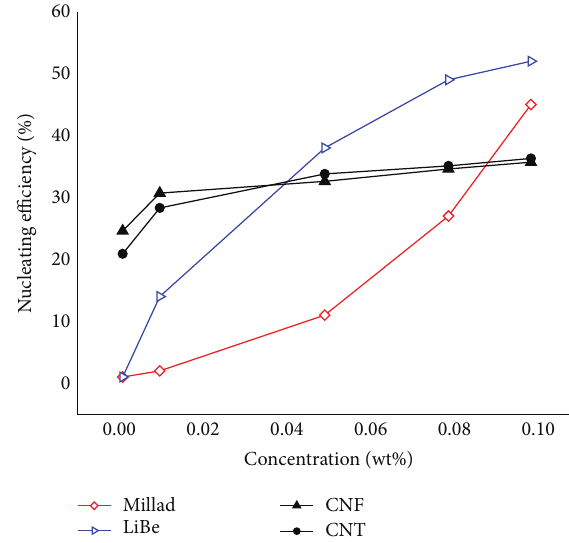
Figure 3: Variation of the nucleating efficiency of the different nucleating agents with their concentration (0.001, 0.01, 0.05, and 0.10